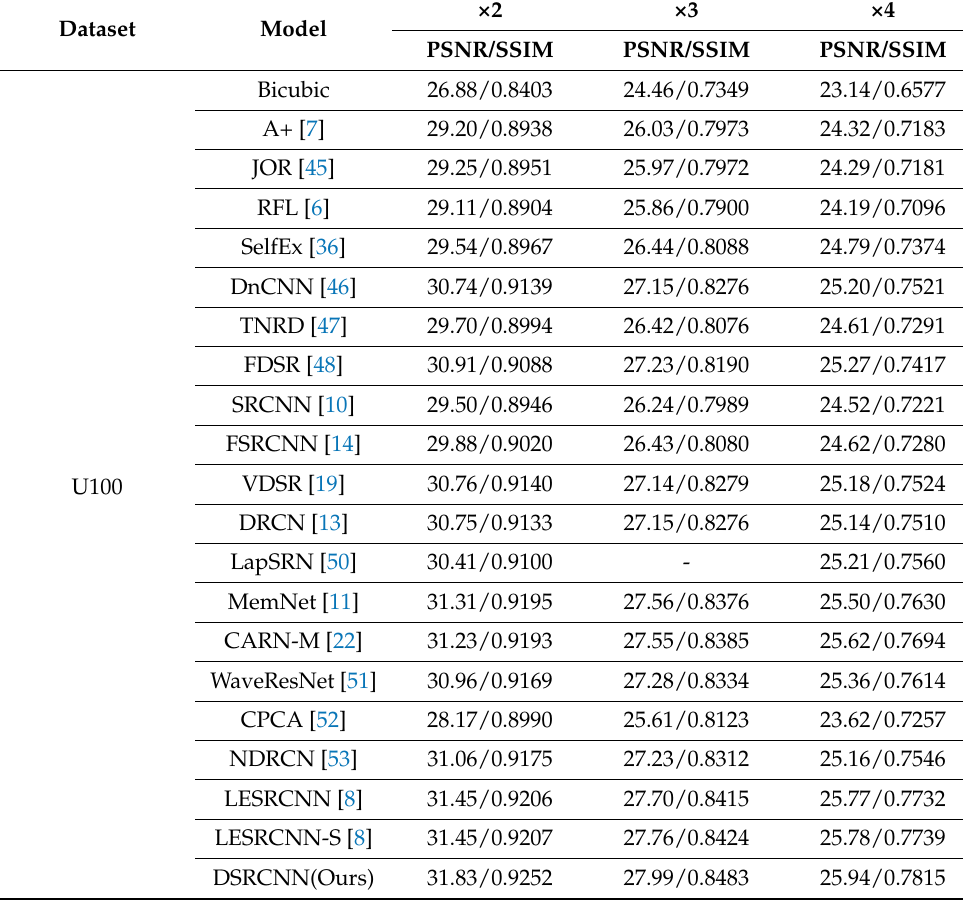
Table 5. PSNR and SSIM of different techniques with scale factors of ×2, ×3, and ×4 on